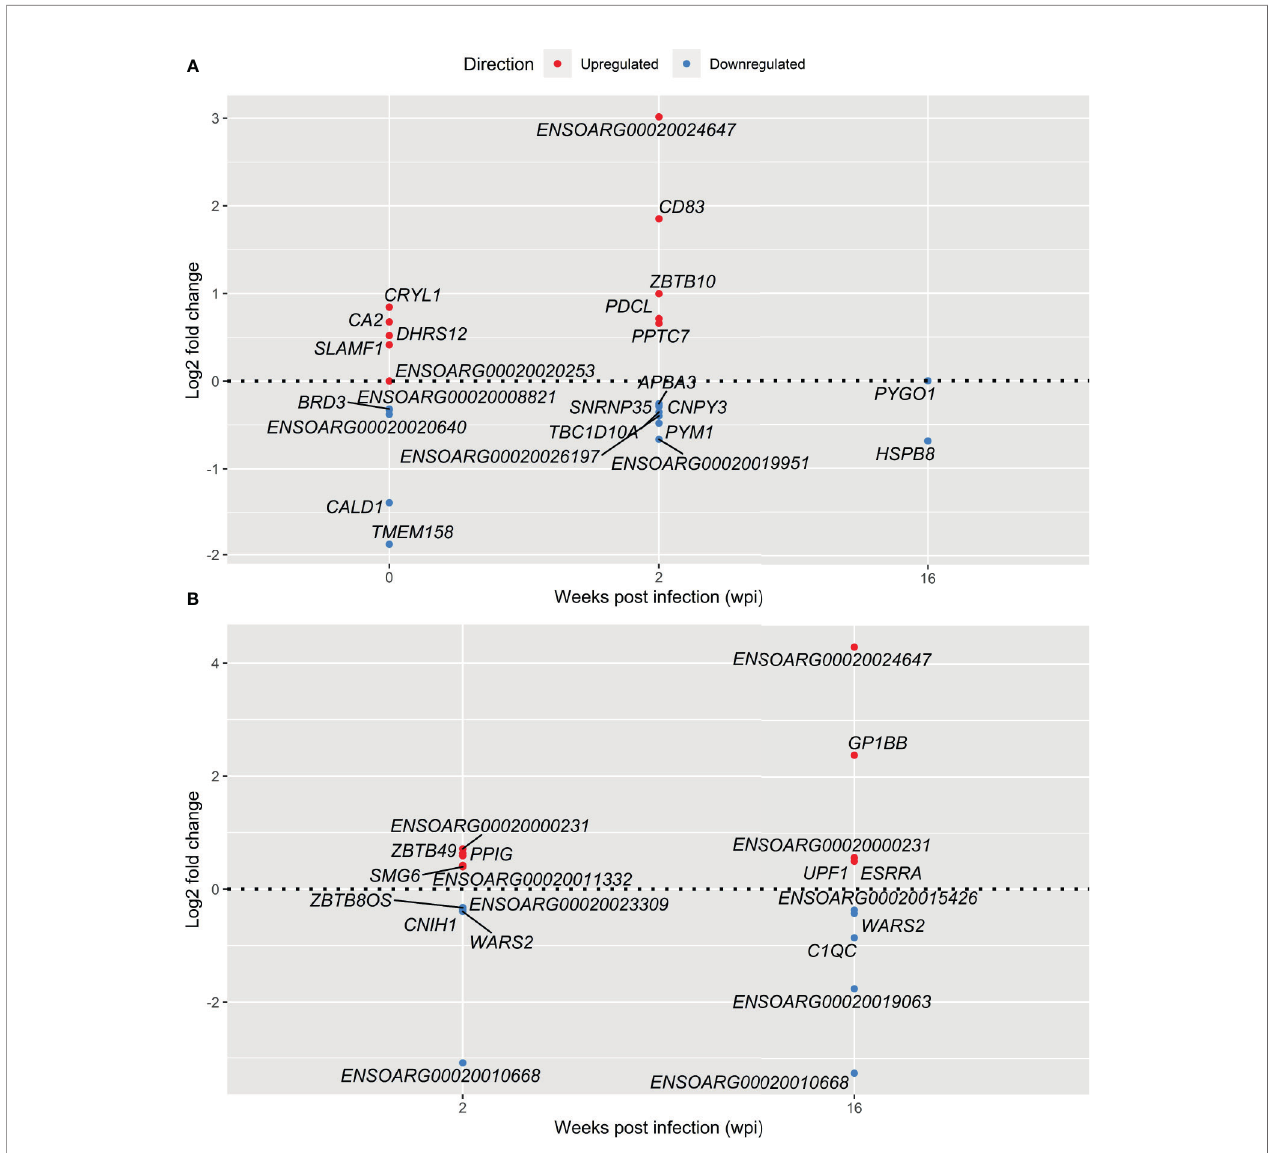
FIGURE 4 | Top 5 most signi fi cant up- and downregulated DE genes in response to infection with F. hepatica - Infected vs Control analysis (A) and Longitudinal analysis (B) . Genes with lowest adjusted P value were selected at each time point. In the case of genes with the same adjusted P value both are